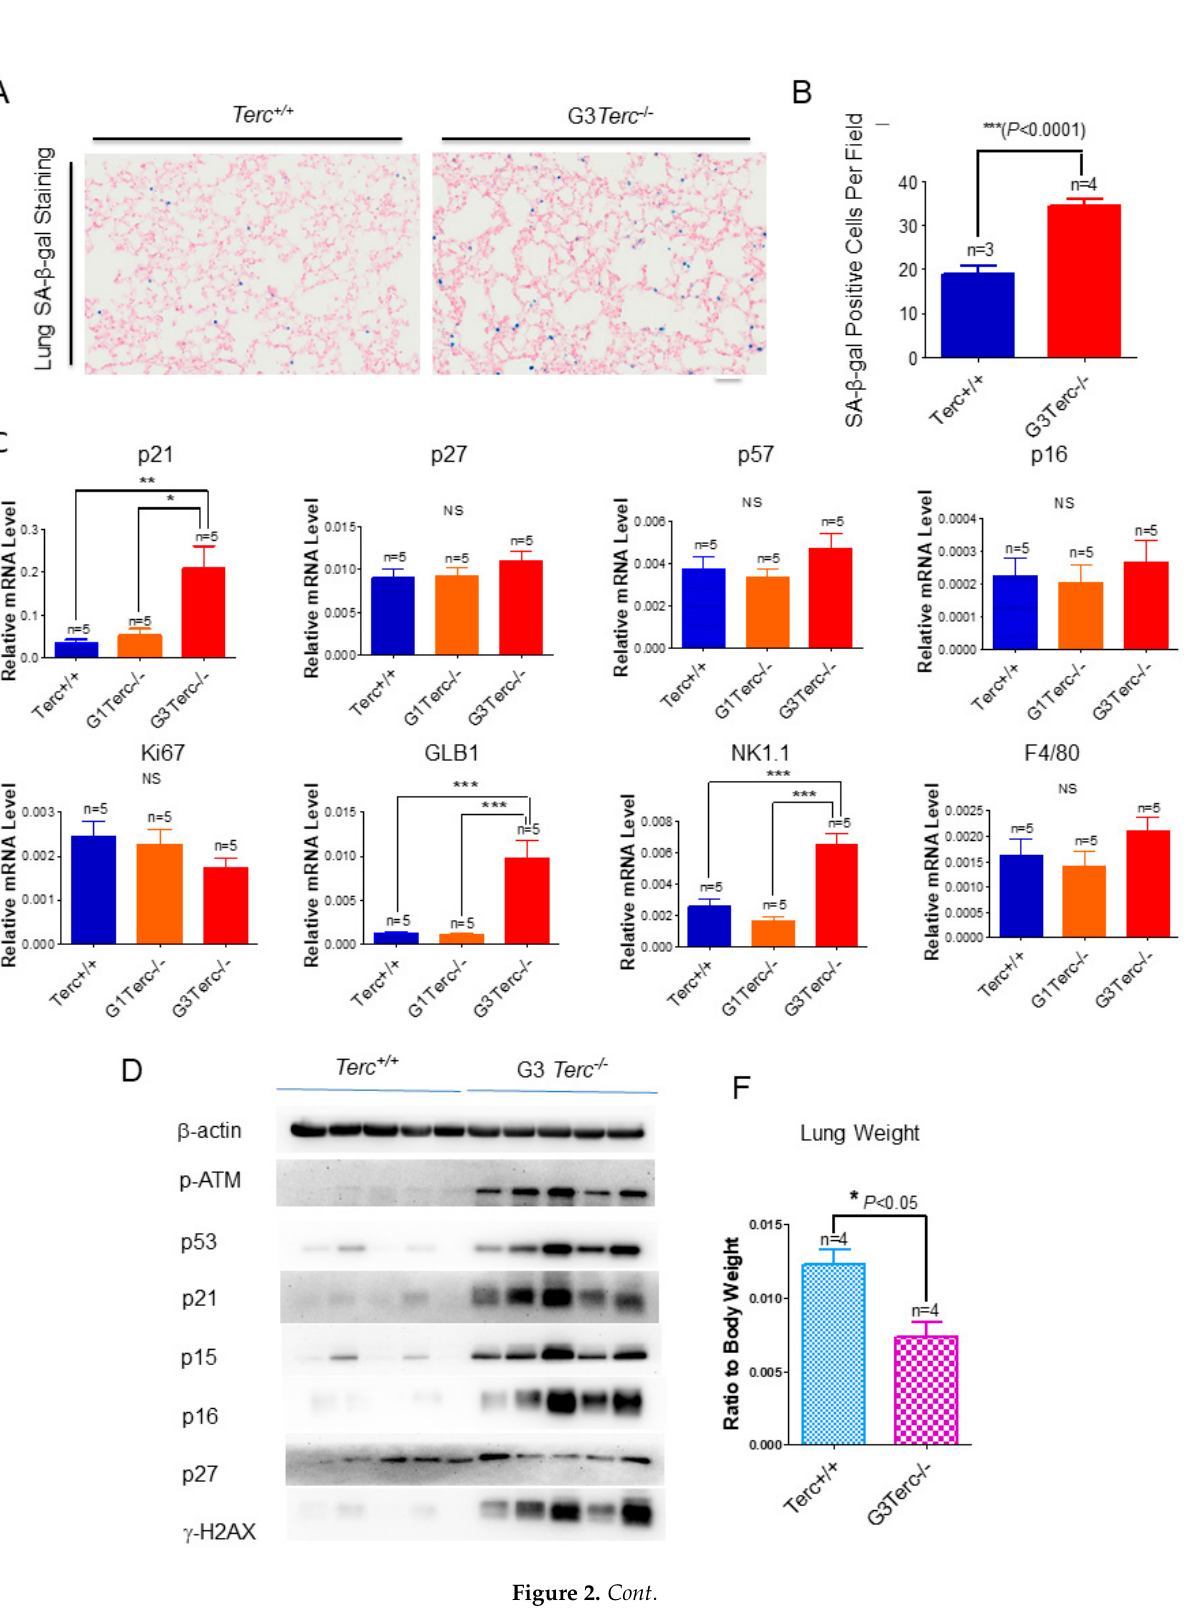
Figure 2. Significant increases in SA- β -gal staining, expression of cell cycle inhibitor p21, lysosomal β -galactosidase-asso- ciated GLB1, and natural killer cell marker NK1.1 in G3 Terc − / − mouse lungs. ( A ) Representative SA- β -gal-stained lungs of Terc +/+ and G3 Terc − / − (magnification: 20×). Scale bar = 100 μ m. ( B ) Quantification of SA- β -gal-stained cells by cell counting (as in A). Data are mean ± SE values based on the indicated number of lungs. ( C ) qPCR analysis of the indicated genes with RNA isolated from the indicated number of lungs by determining the relative mRNA level (ratio to β -actin). ( D ) Western blotting analysis with proteins from the lung tissues. ( E ) Representative NK1.1-stained lungs of Terc +/+ , G3 Terc − / − (magnification: 40× and 80×). Scale bar = 50 μ m. ( F ) The analysis of lung weight change by calculating the ratio to body weight based on the indicated number of mice. Statistical significance is indicated by * p < 0.05, ** p < 0.01, *** p < 0.001. 3.3. Pulmonary AEC2 Stem Cells Undergo Senescence by Mechanisms Involving p21 in Mice Deficient of the Telomerase RNA Component To identify the cell type(s) showing a senescent phenotype, we performed double immunofluorescence staining on pulmonary alveolar stem AEC2 cells by SPC (surfactant protein C) and each of p21, p16, or Hp1 γ . We found that the cell cycle inhibitor p21 was significantly higher in AEC2 cells of the lung sections in G3 TERC KO mice versus the WT